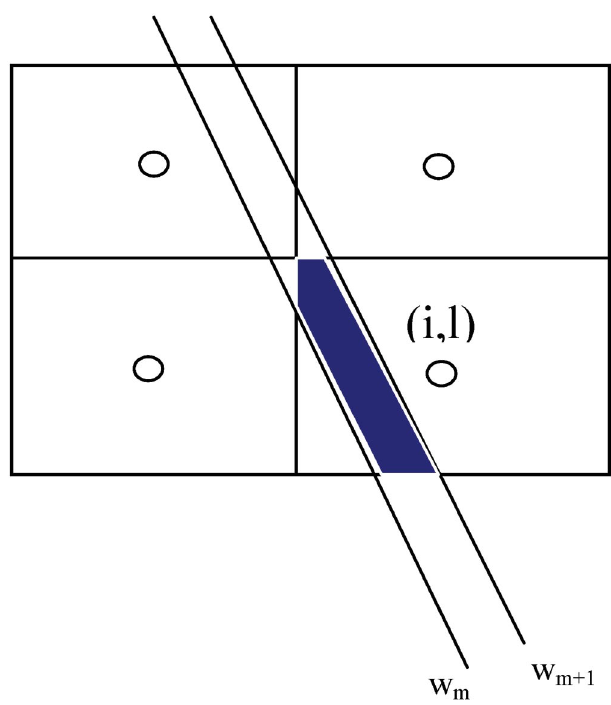
FIG. 2. (Color) Element P , the projection of grid- j (cid:13) m;N 2 (cid:13)(cid:1) i (cid:5) 1 (cid:2)(cid:8) l box ( i; l ) onto the m th pixel at angle ’ , is equal to the shaded area of